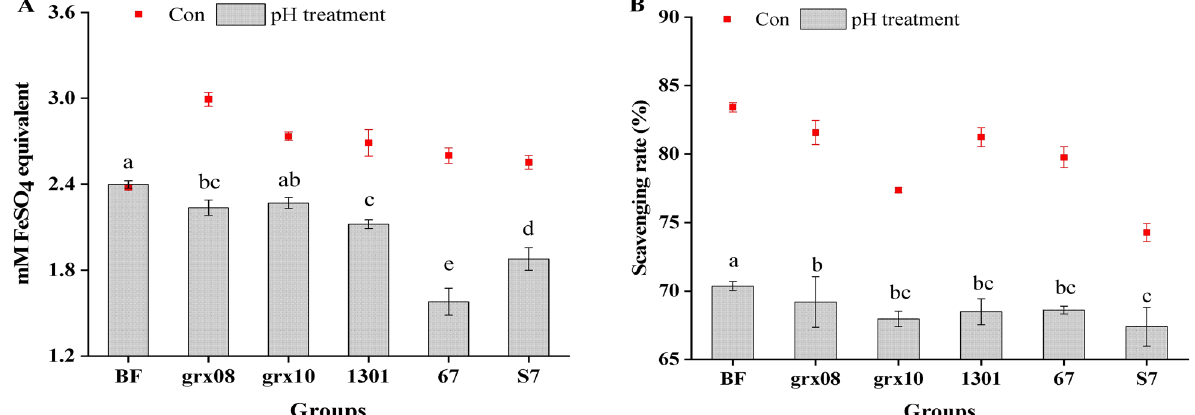
Fig. 5 Comparison of the antioxidant properties of the FH06 extract before and after adjusting the pH to 7.0. A Total antioxidant capacity (FRAP value); B DPPH scavenging rate. Data are expressed as the mean standard deviation (SEM). "Con" means the supernatant stock before and after · ± fermentation; "pH treatment" refers to adjusting the supernatant stock before and after fermentation with a saturated NaOH solution to a pH of 7.0. Note: different letters indicate significant differences among groups after pH adjustment ( P < 0.05)